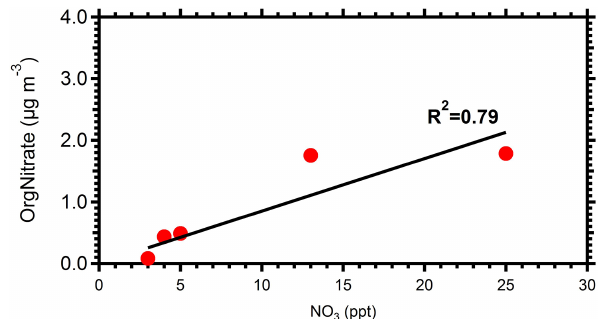
Figure 8. Correlation between NO 3 radicals with the organic nitrate formed in the perturbed